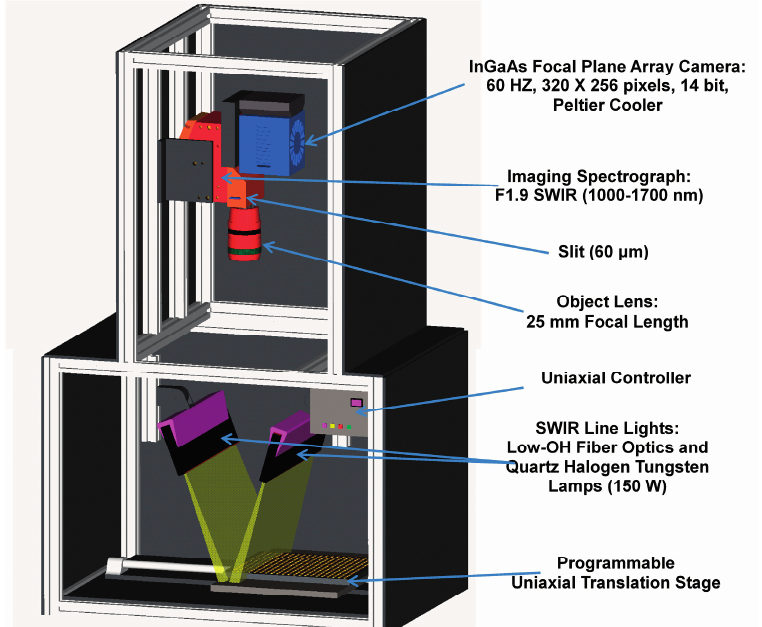
Figure 1. Schematic illustration of the critical components of the hyperspectral NIR imaging